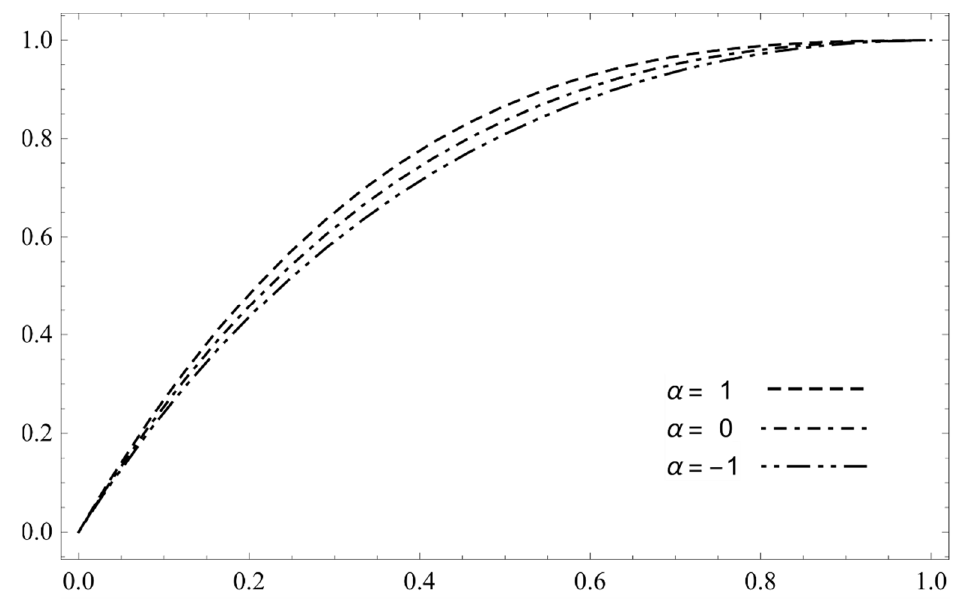
Figure 11. Behavior of f ( y ) using RKHSM with Re = 1. Figure 12 shows the streamlines and velocity field for Re = 5 and α = 1 that were obtained employing the FDM for PDEs.